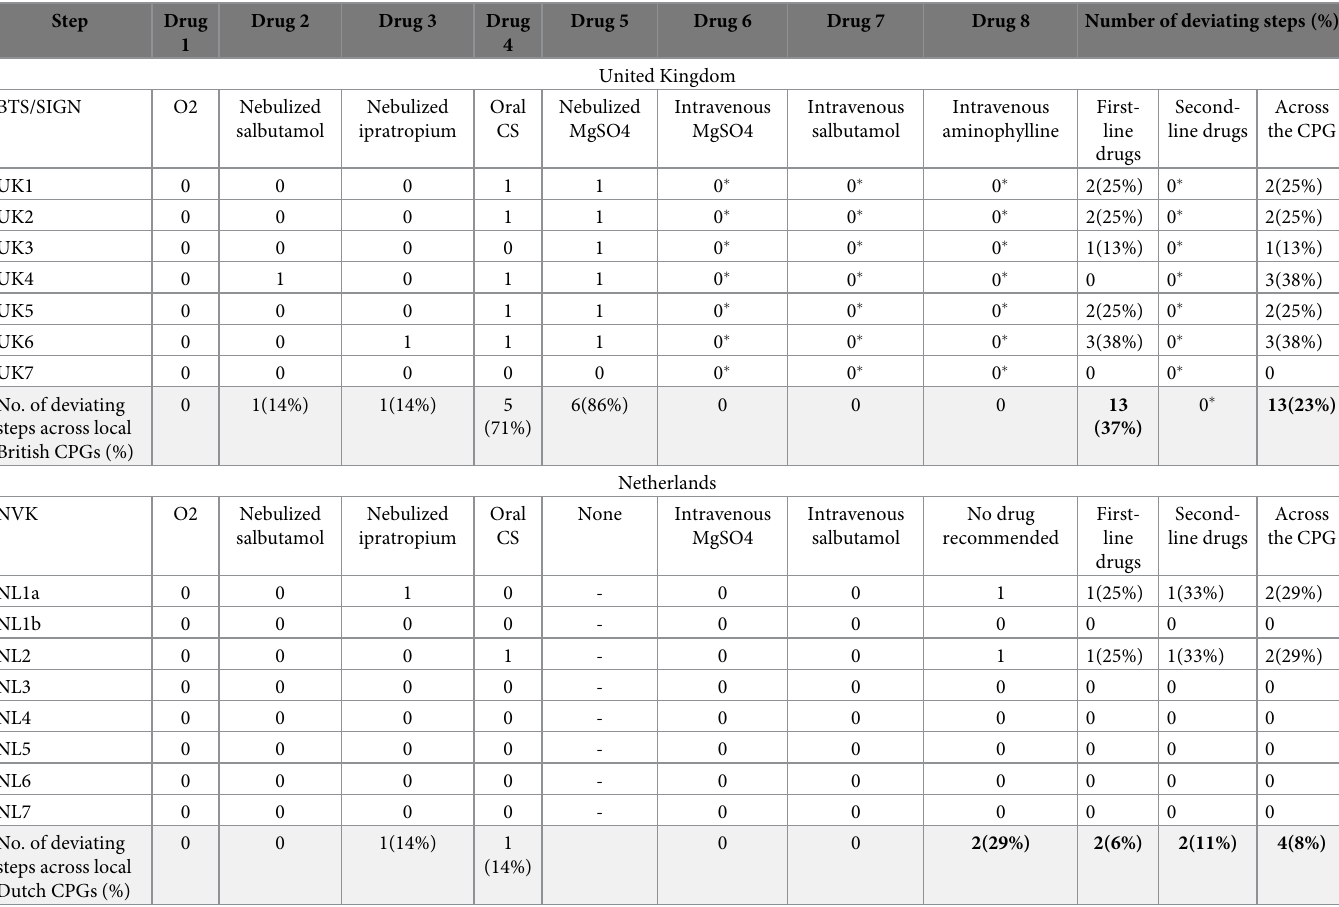
Table 2. Quantitative assessment of deviations from national guidance across sampled local British and Dutch CPGs.